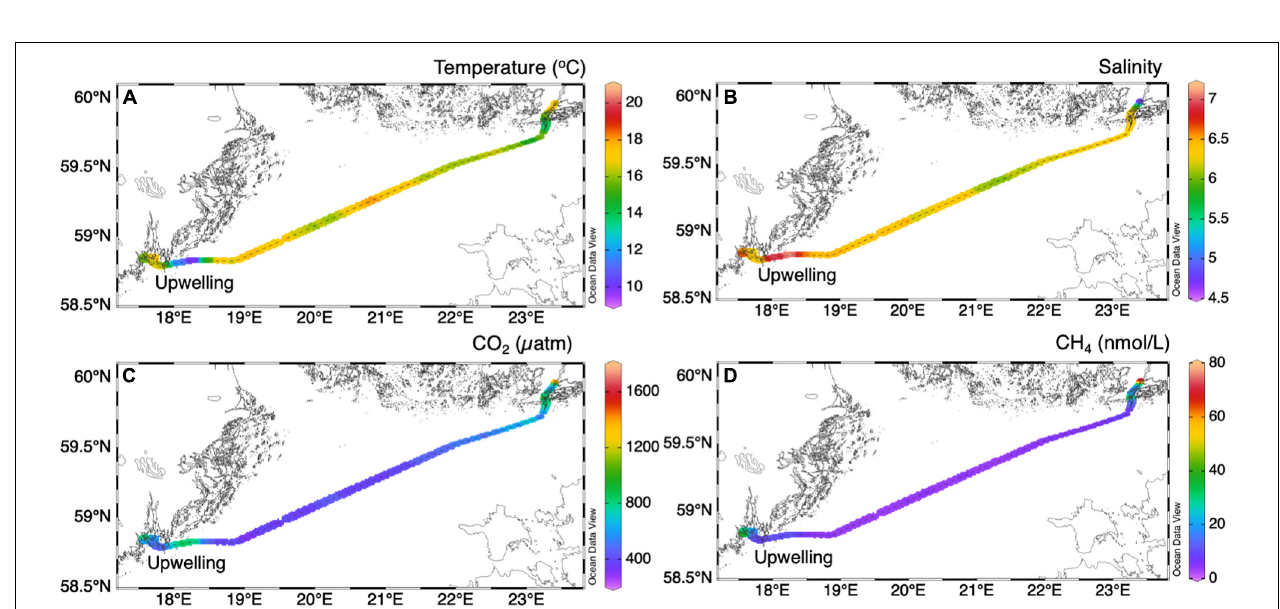
FIGURE 4 | Cross section from Askö to Tvärminne of (A) temperature, (B) salinity, (C) pCO 2 ( µ atm) and (D) CH 4 concentrations (nmol/L) in surface waters.